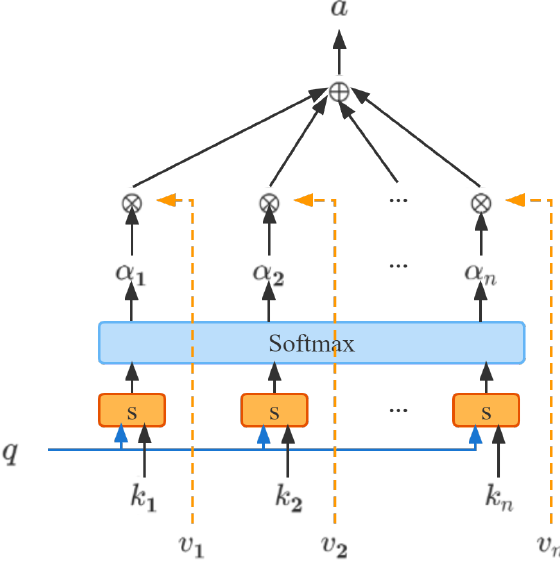
Figure 2. The key-value attention